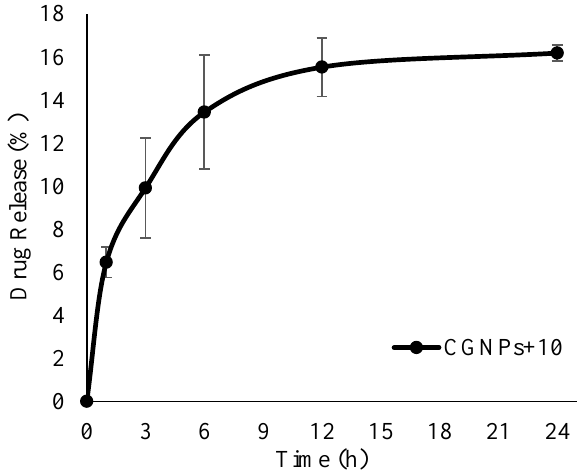
Figure 7. Cumulative percentage of α -tocopherol release from CGNPs+10. Mean ± SD, n = 3. Y = 0.00303 + x, r = 0.99986.